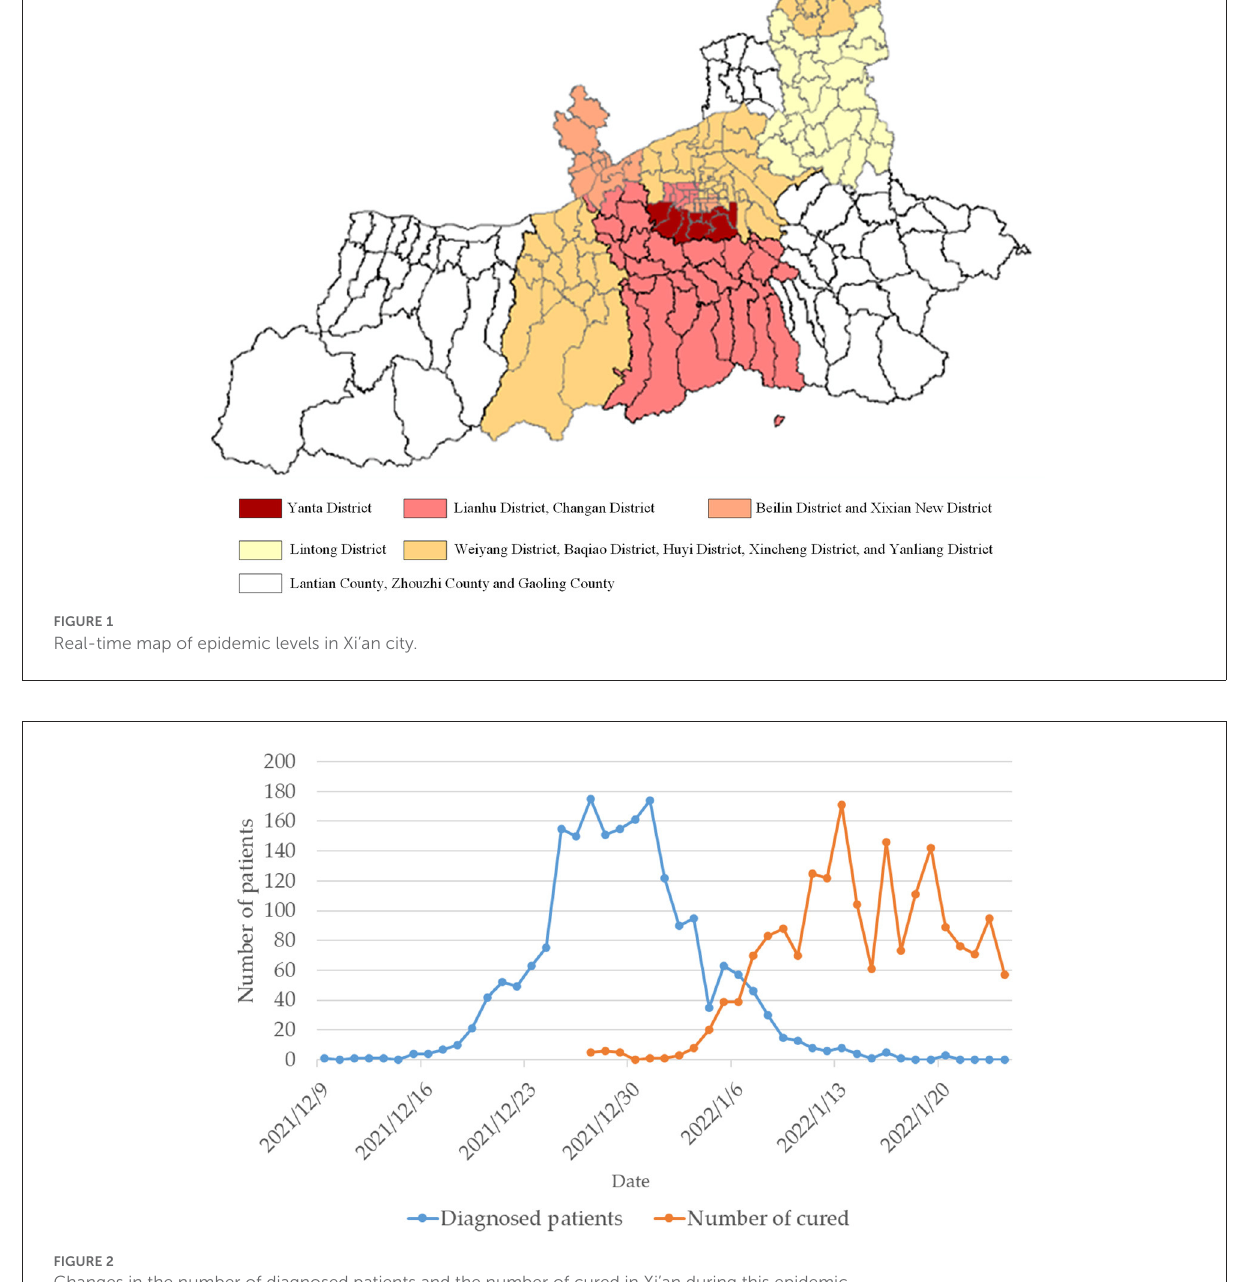
FIGURE2 Changes in the number of diagnosed patients and the number of cured in Xi’an during this